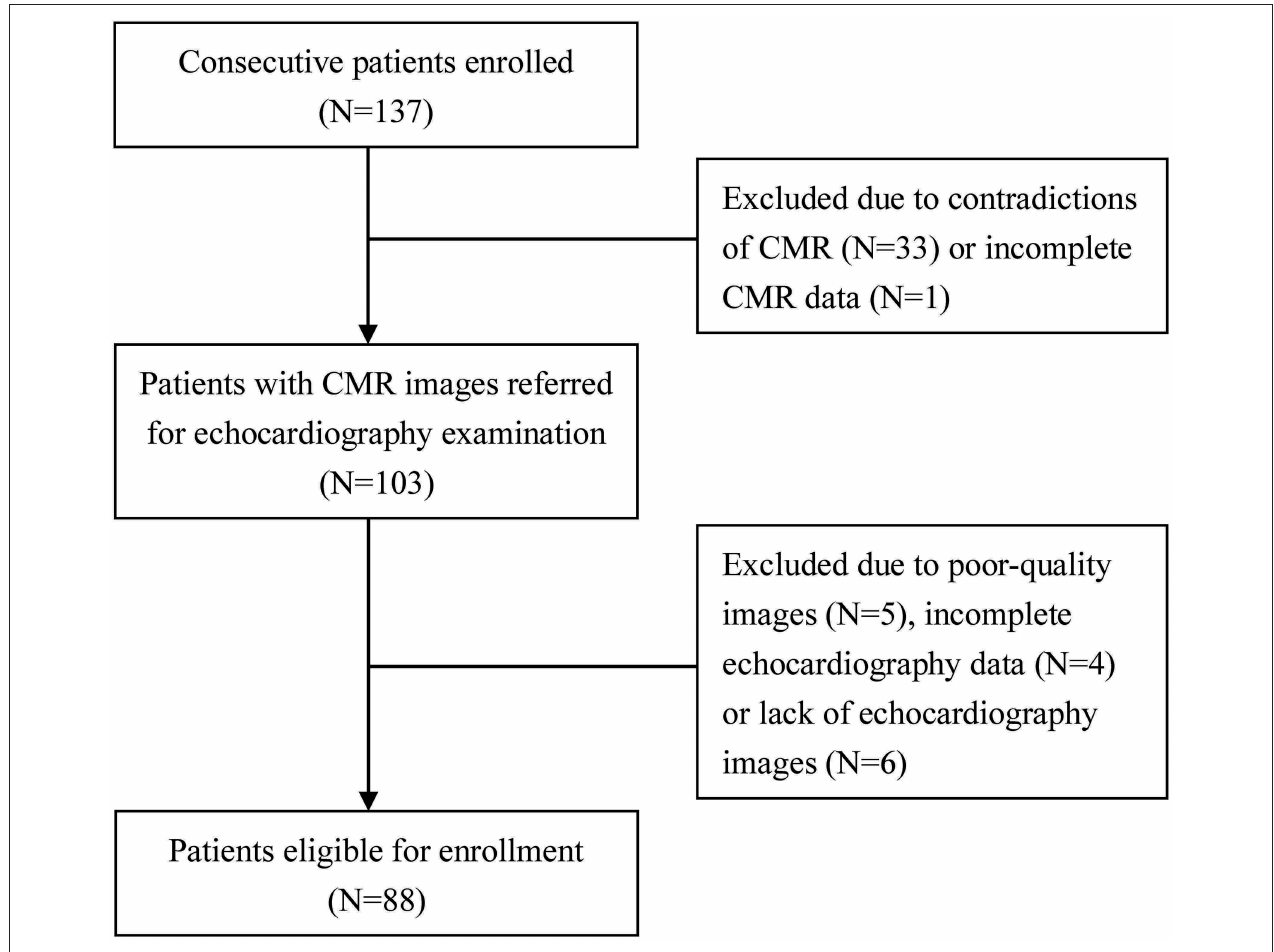
FIGURE 1 | Flow chart of the